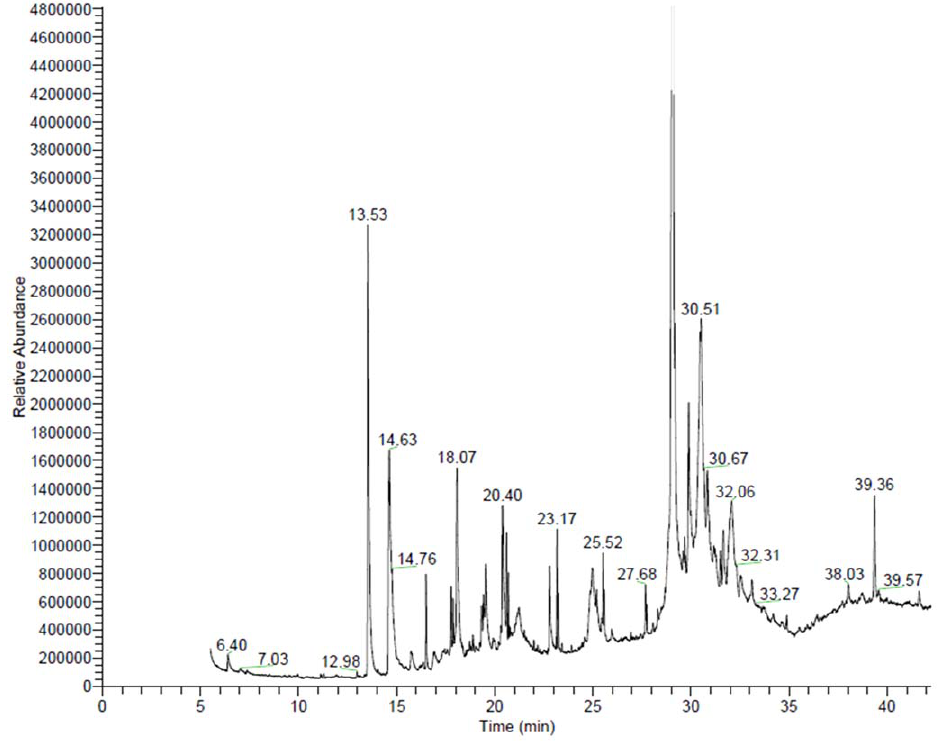
Figure 4. GC/MS chromatogram of ethyl acetate root extract of R.imbricata .